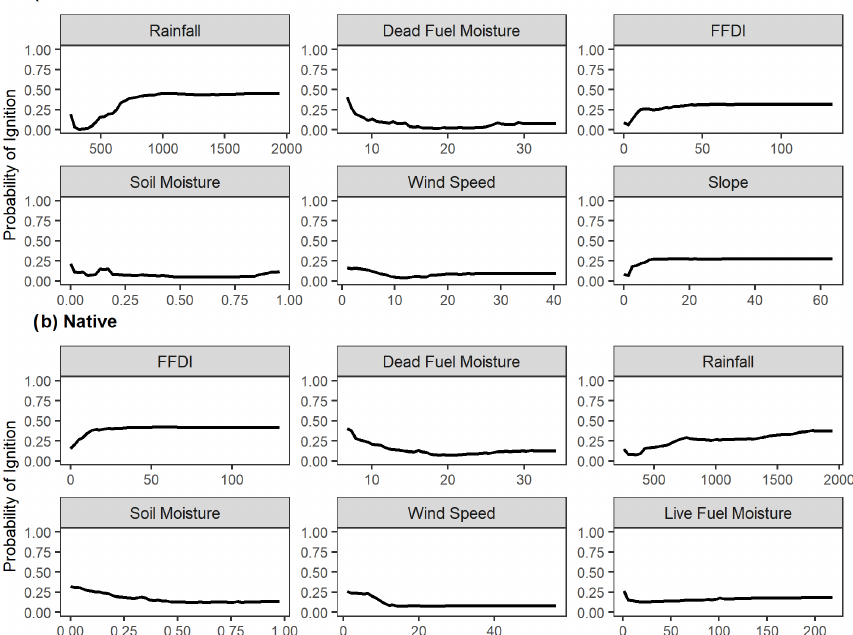
Figure 5. Partial dependence plot for the six top predictor variables in the random forest models predicting whether a lightning flash has any probability of starting a fire in (a) matrix and (b) native forest. Variables are plotted in order of importance. Black lines represent the average probability of ignition from the 10 models used in the cross-validation. Grey error bars represent the upper and lower estimates from the 10-fold cross-validation.